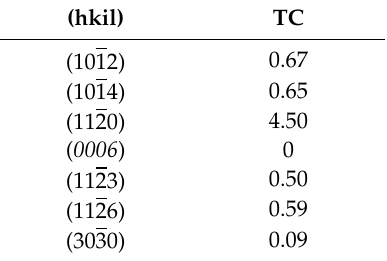
Table 5. Texture coefficients for α -Al 2 O 3 coating deposited at H 2 S = 0.